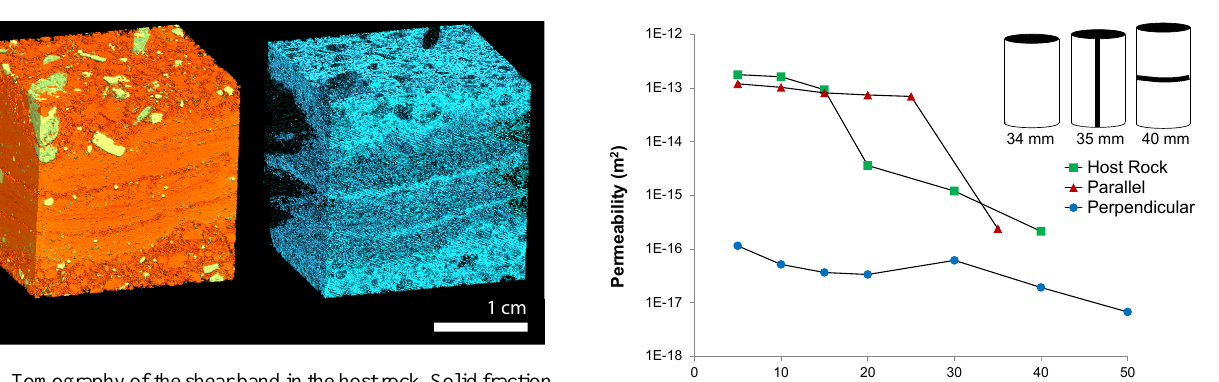
Fig. 3. Tomography of the shear band in the host rock. Solid fraction of the sample is shown in yellow (oxides, amphibole and pyroxenes) and orange (plagioclase and groundmass). A 3-D reconstruction of the pore space is shown in blue, highlighting the negligible poros- ity of the pseudotachylyte layers. Pores were selected as areas with grey level of 0 (black only), hence the figure may under-represent the porous fraction. Images have a pixel/voxel size of 20.0µm, 1000 images for 360°(average of 3 single images, one image skipped), with exposure time of 1s.